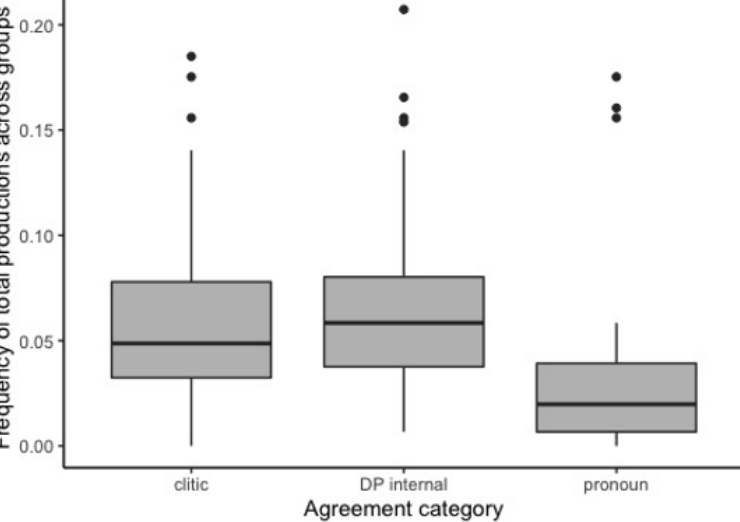
Figure 3. Normalized frequency of total productions for each agreement category (clitic, DP internal, pronoun) across countries (USA, Greece) within the adults’ group.